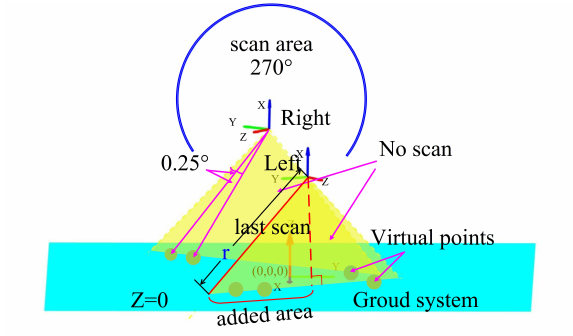
Figure 5. Blind angle of the Lidar (yellow) and virtual comple- tion.